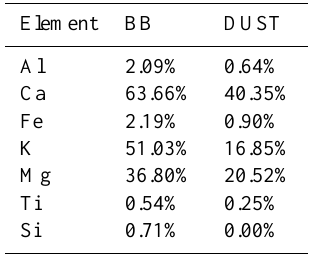
Table 3. Median solubility of major terrigeneous elements in BB and DUST